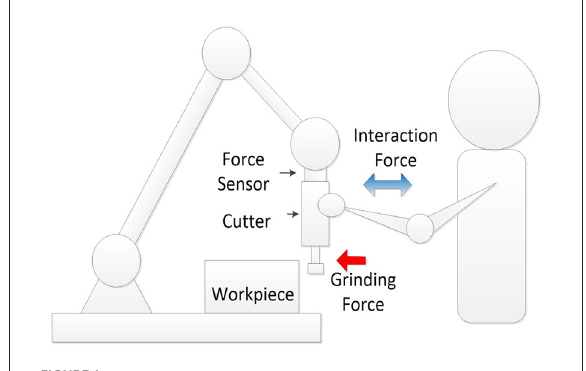
FIGURE1 Human–robot collaborative grinding.